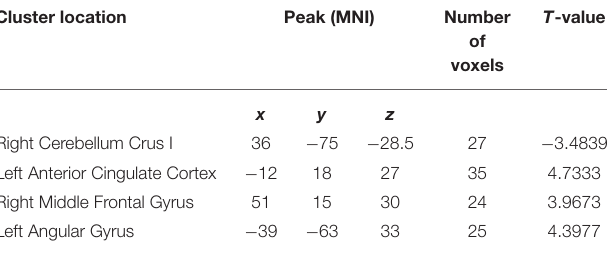
TABLE 2 | Regions with abnormal gray matter volume in the patients.